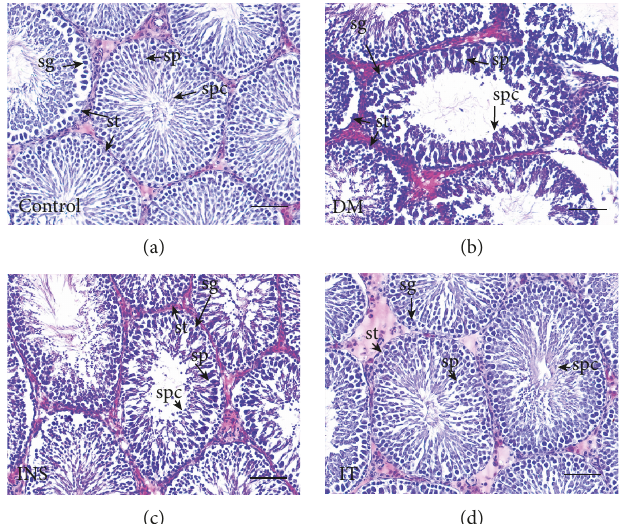
Figure 2: Islet transplantation treatment improved pathological lesions in diabetic rat testes. Representative images of testicular histological examination in each group ( n = 6 for each group) (HE staining: × 200). Bar = 50 μ m . (a) Testicular slices of the control group showed normal spermatogonia (sg), spermatocytes (sp), seminiferous tubules (st), and sperm cells (spc). (b) Testicular slices of the DM group showed spermatogonial cells, spermatocytes, and sperm cells that were degenerated and vacuolated, as well as severely reduced germ cells. (c, d) Testicular slices of the IT group demonstrated more signi fi cant recovery of testicular structures compared with that of the INS group. DM: diabetes mellitus; INS: insulin treatment; IT: islet transplantation.